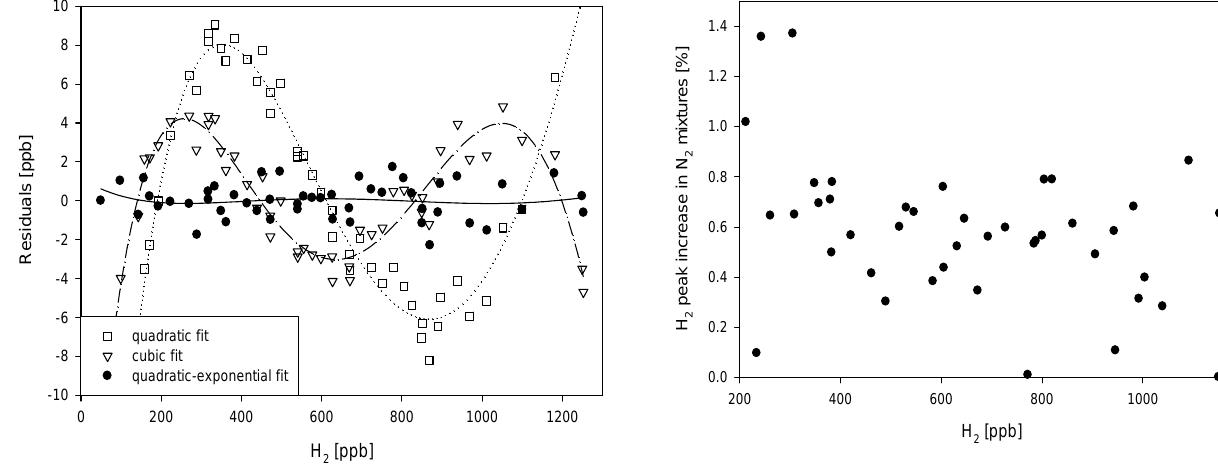
Figure 9. Relative increase of the normalized H 2 peak height in N 2 mixtures compared to H 2 2 Fig. 9. Relative increase of the normalized H 2 peak height in N 2 in air mixtures [%] 3 mixtures compared to H 2 in air mixtures [%].